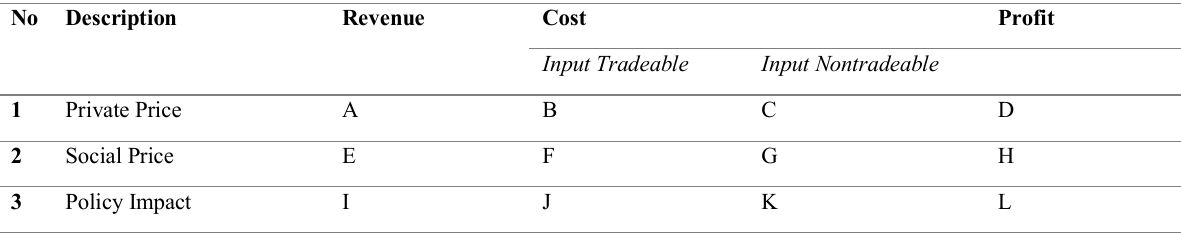
Table 2: Policy Analysis Matrix